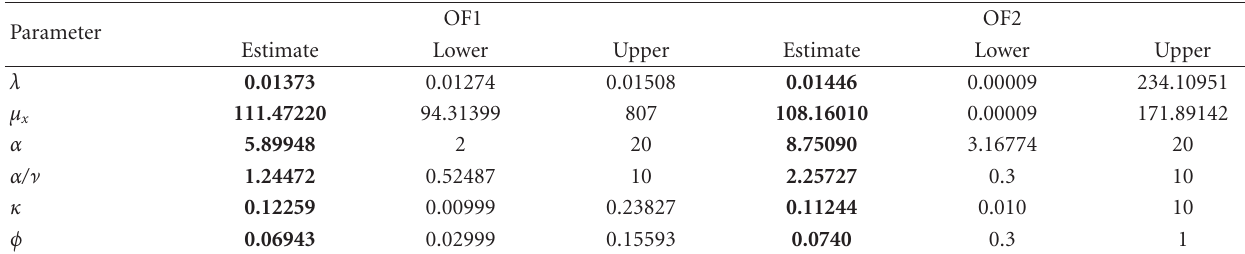
Table 5: A comparison of results found using OF1 and OF2 on the parameter estimates and 95% confidence intervals for data of July based on model